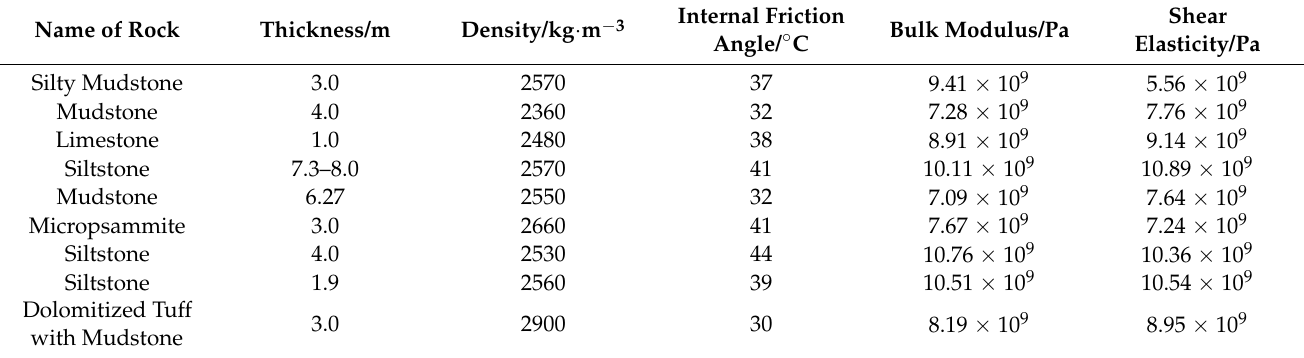
The geology parameters are based on Table 2 below. Table 2. Geology